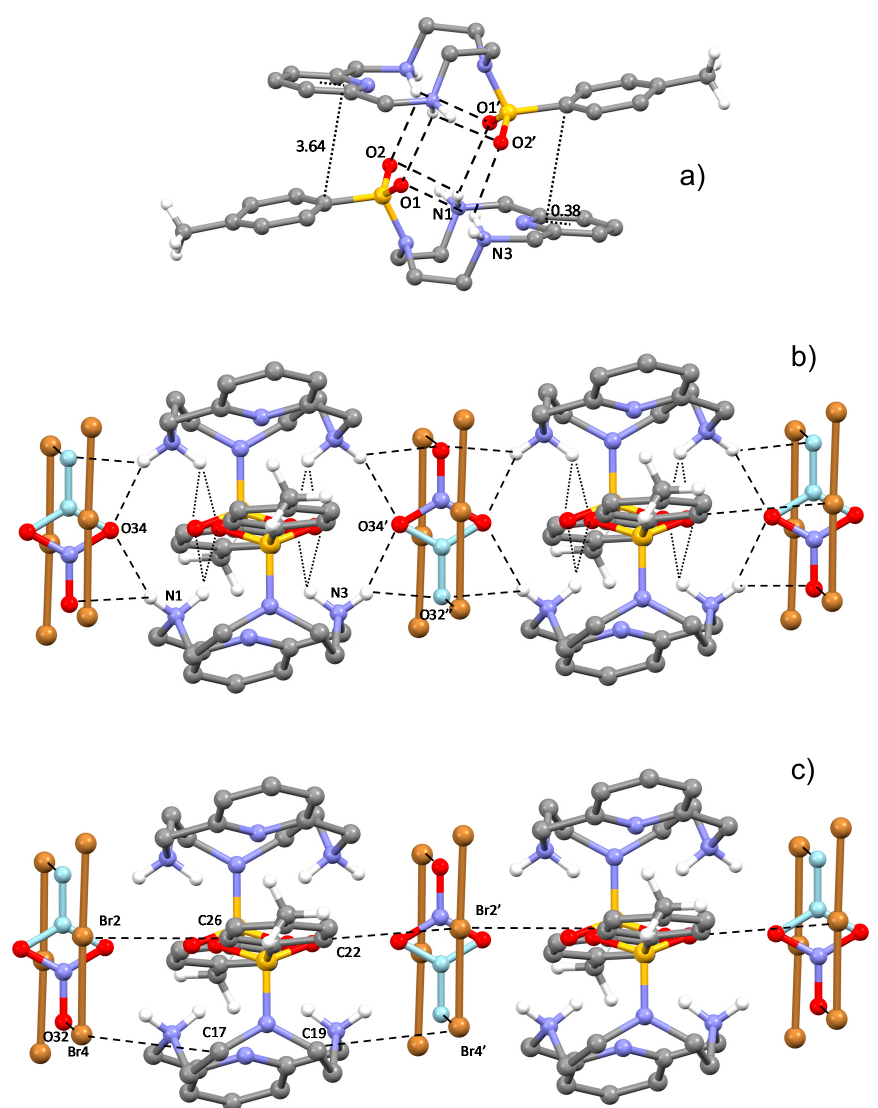
Figure 3. Views of the crystal structure of (H 2 L-Ts)(Br 3 ) 1.5 (NO 3 ) 0.5 . ( a ) (H 2 L-Ts) 2+ ligand pairs; distances in Å. ( b ) Interactions formed by NO 3 − anions; only one of the possible motifs compatible with this pseudosymmetric disorder is shown. ( c ) Interactions formed by one of the non-equivalent tribromide anions.